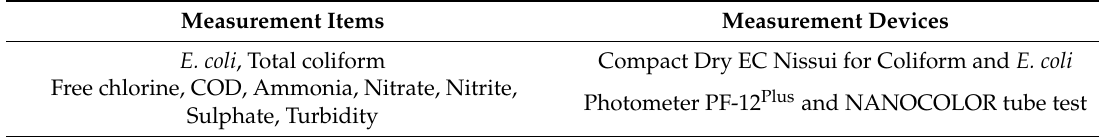
Table 2. Measurement kit and device to measure water quality of tap